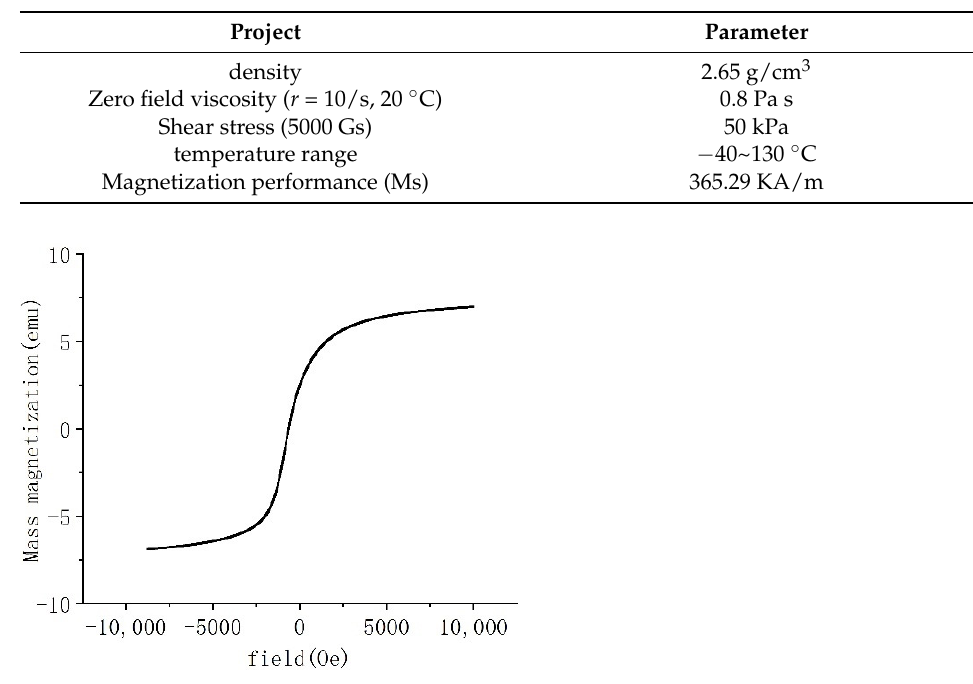
Figure 2. B–H curve of MRF-J25T.